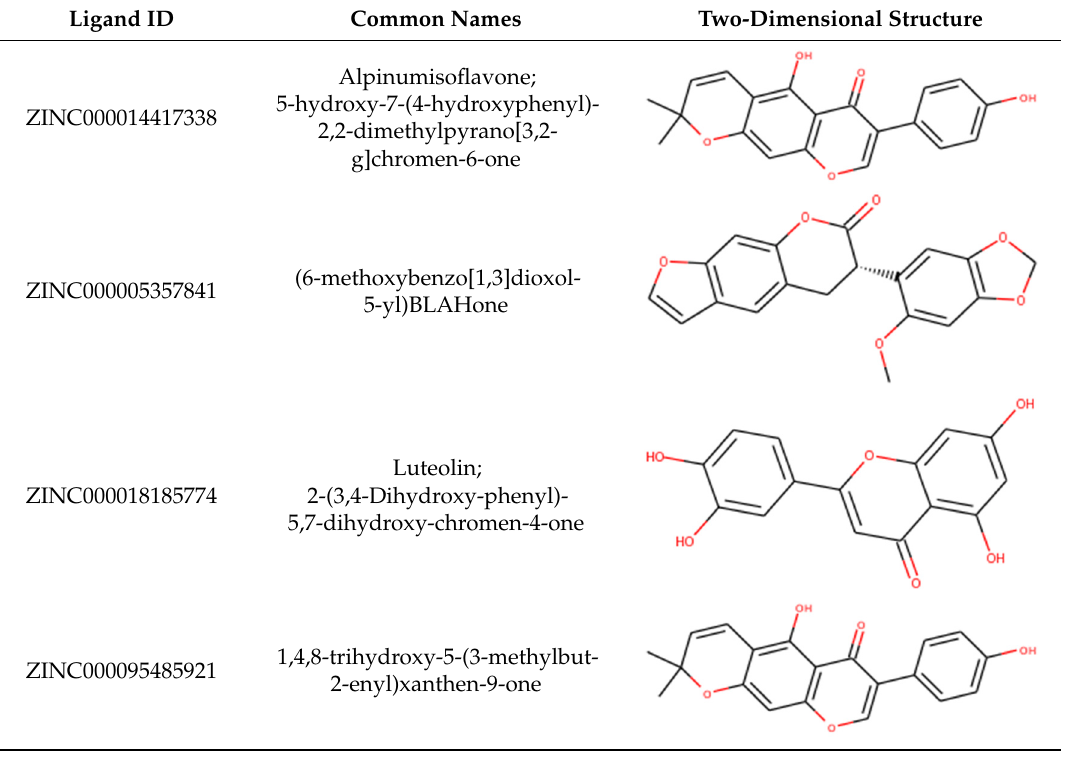
Table 9. List of predicted lead compounds, their common names and two–dimensional structures obtained from Zinc database.